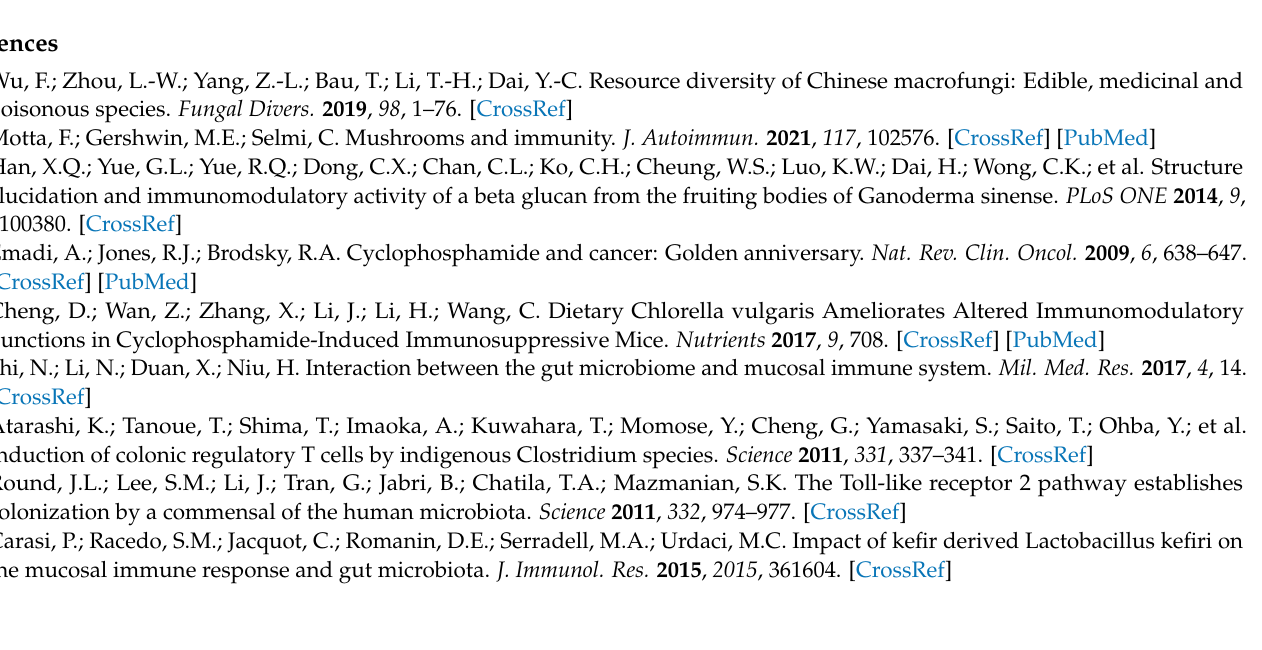
Figure S2: Structural characterization of PAPS1. Two-dimensional NMR atlas of (A) 1H-1H COSY, (B) HSQC, (C) 1H-1H NOESY and (D) HMBC; Figure S3: PAPS1 showed no histopathological effect on the livers and kidneys of CTX-injected mice. H&E staining and histopathological observation of the (A) liver and (B) kidney (magnification: 200 × , scale bar: 100 µ m); Table S1: Primary antibodies used for immunohistochemistry staining; Table S2: ELISA kits used for the assessment of biochemical indices; Table S3: Molecular characteristics of PAPS1; Table S4: Effects of PAPS1 on body weight and organ index in 70 mg/kg-CTX-induced immunosuppressed mice; Table S5: The number of microbial taxa at different levels of intestinal microflora in mice; Table S6: The relative abundance of each node of intestinal microflora in mice. References [20,22] are cited in the supplementary